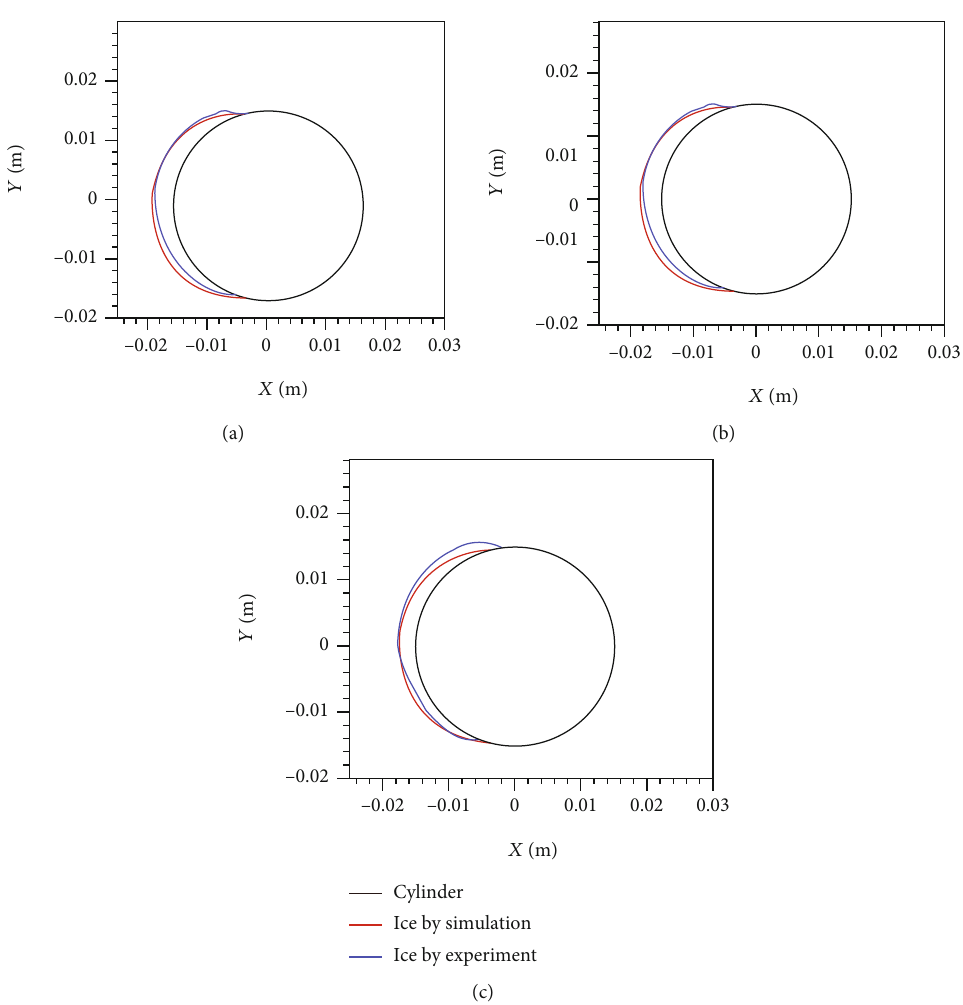
Figure 12: Icing shape comparison between test and simulation: (a) glaze ice, (b) mixed ice, and (c) rime